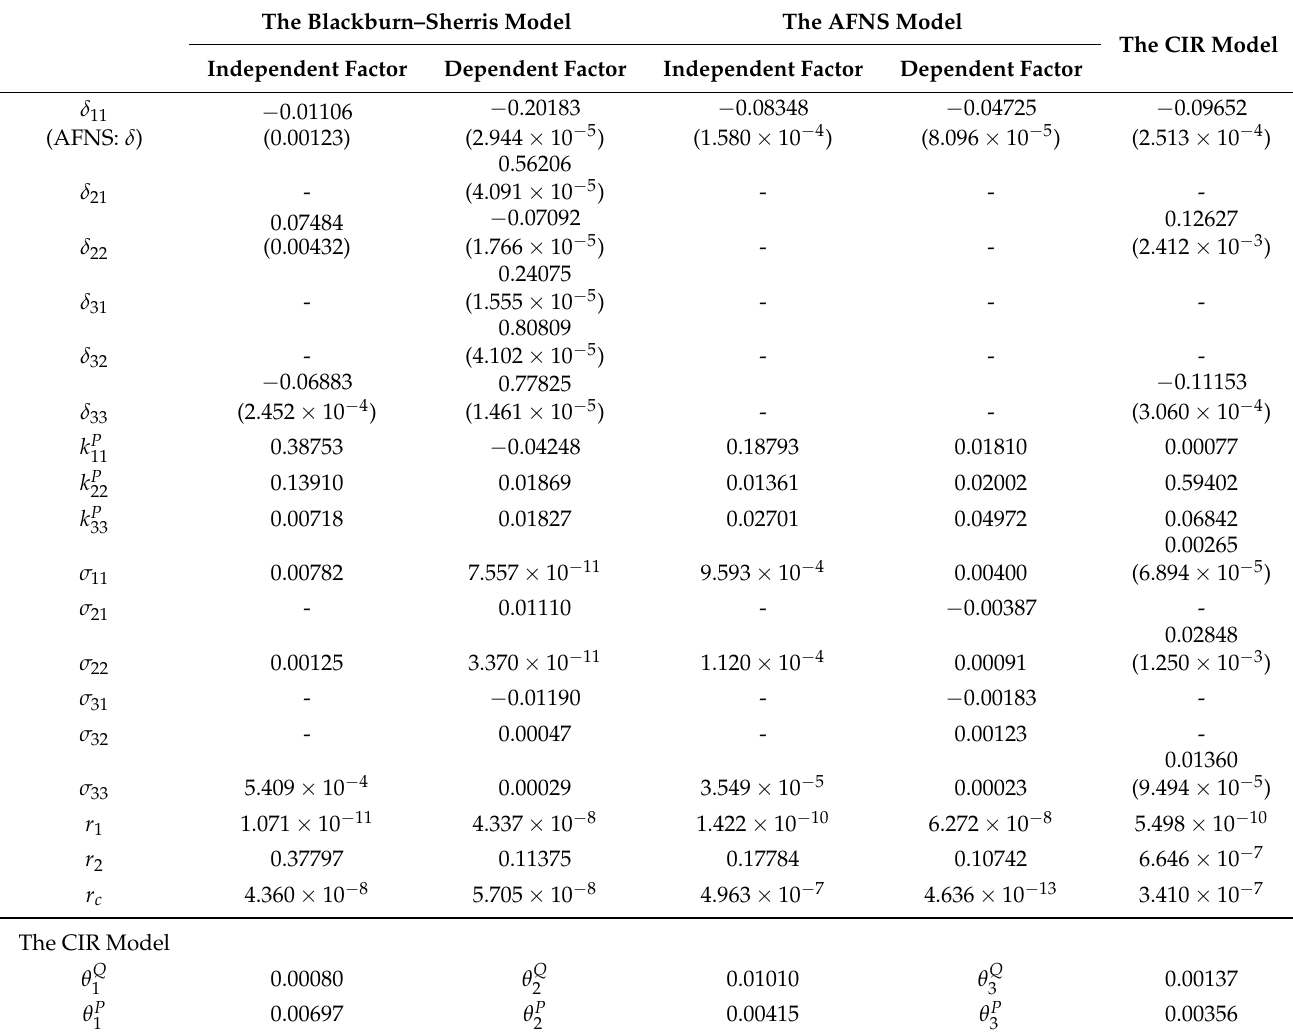
Table 2. Estimated